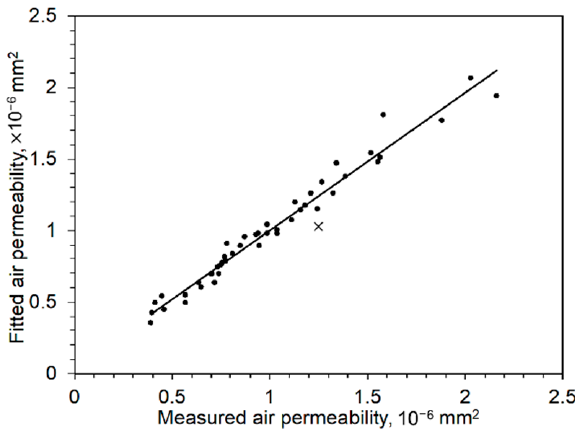
Figure 15. Comparison between fitted permeability and experimental permeability.